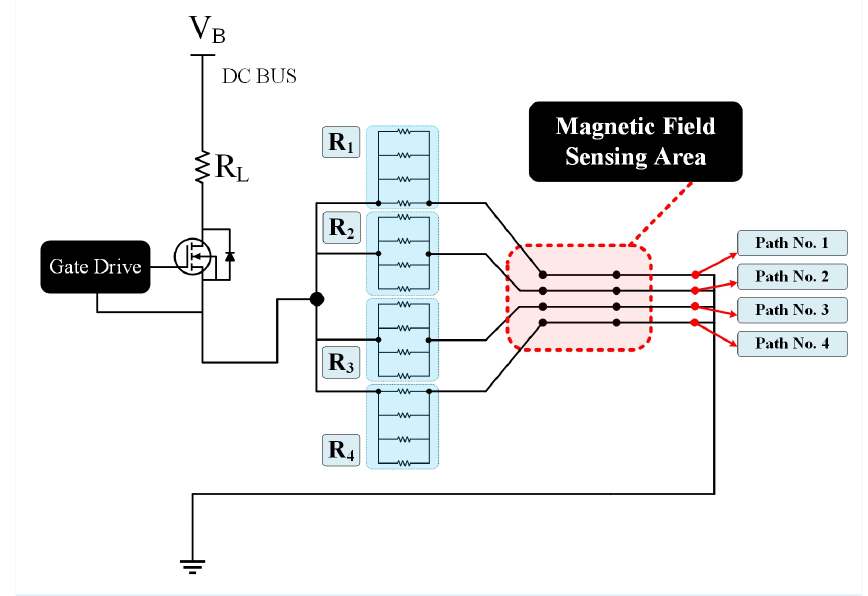
Figure 12. Resistive-based current sharing circuit for magnetic sensor calibration.